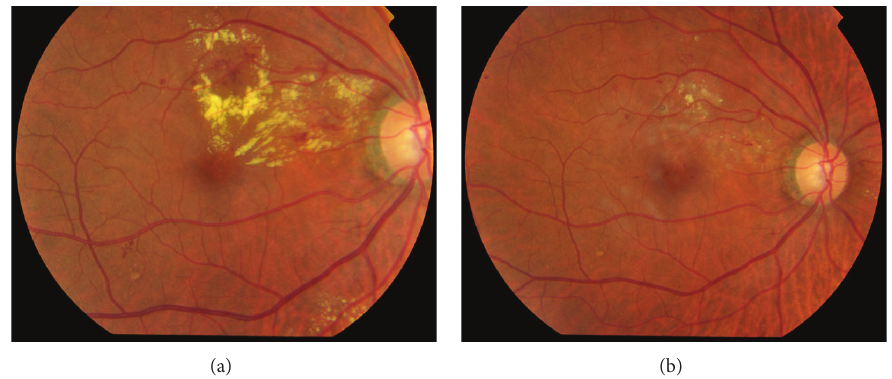
Figure 1: CSME (a) before and (b) after focal laser photocoagulation.